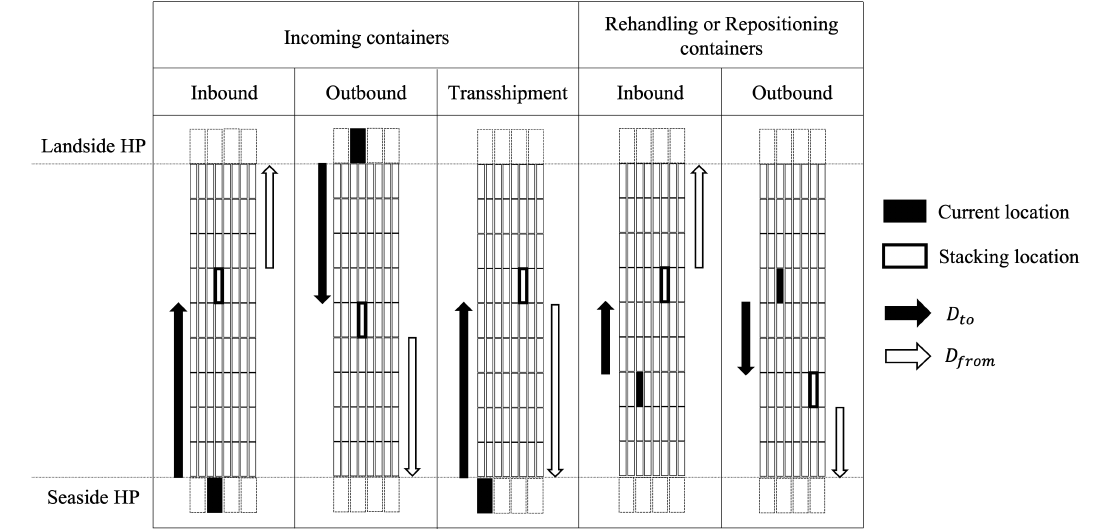
Figure 2. D to and D from depending on the type of